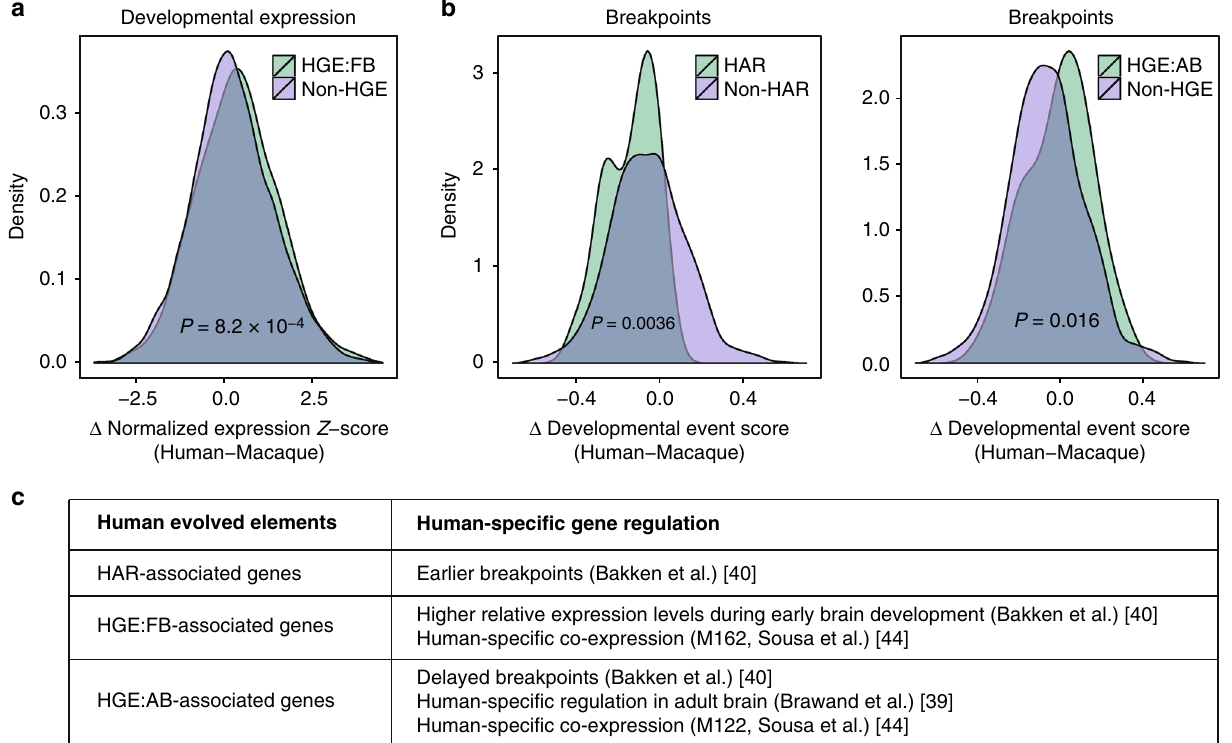
Fig. 3 Human evolved elements mediate human-speci fi c regulation. a HGE FB -associated genes show relative higher expression during early brain development in human compared with rhesus macaque. P -values calculated by two-sided t -tests. b HAR-associated genes show earlier breakpoints, while HGE AB -associated genes show later breakpoints. P -values calculated by two-sided Wilcoxon rank sum tests. c Distinct classes of human-evolved elements are associated with different types of human-speci fi c gene